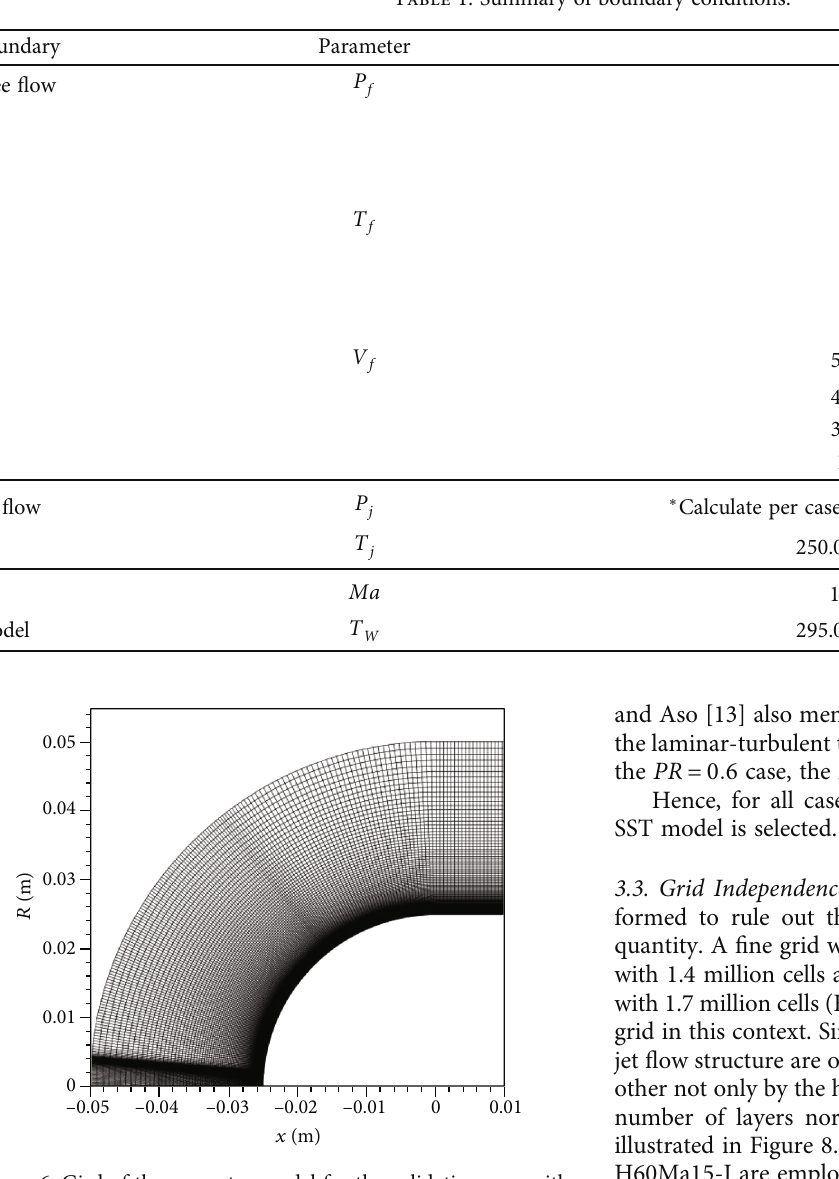
Figure 6: Gird of the geometry model for the validation case with